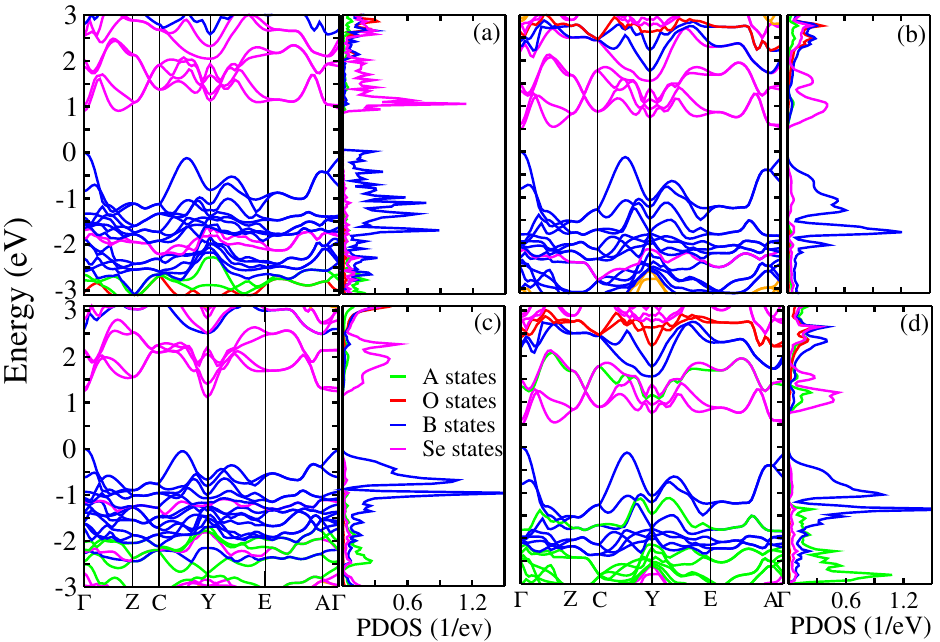
Figure 2. (color online) Calculated band structures and partial density of states for ( a ) Sr 2 O 2 Bi 2 Se 3 , ( b ) Sr 2 O 2 Sb 2 Se 3 , ( c ) Ba 2 O 2 Bi 2 Se 3 , and ( d ) Ba 2 O 2 Sb 2 Se 3 . A refers to Sr or Ba and B replaces Bi or